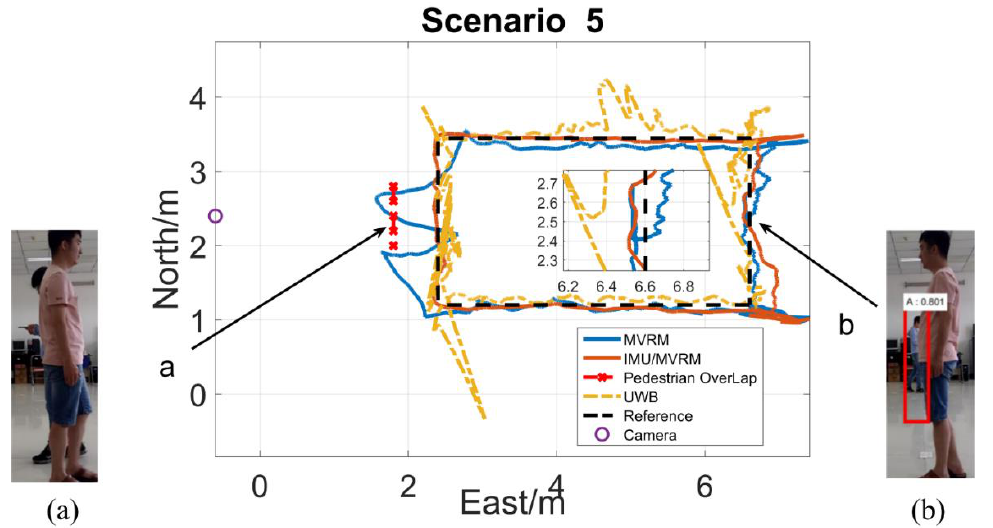
Figure 16. The horizontal trajectory in garbage can scenario. ( a ) The garbage can blocked the little view of the camera from seeing the test person at the marker 10th, and succeed to detect but caused little image height errors; ( b ) the stool is not able to block any view of the camera from seeing the test person near the marker 21st, and succeed to precisely detect.